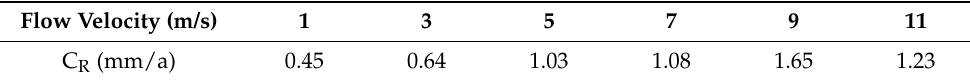
Table 5. Corrosion rates of 304L stainless steel at different flow velocities. Flow Velocity (m/s)